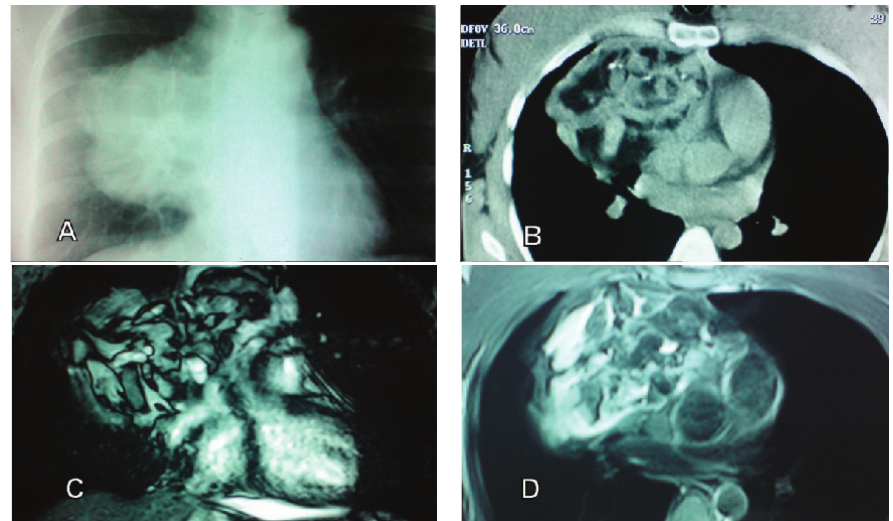
Figure 1: (A) Mediastinal lesion on chest radiography. (B) A mass with heterogenous density and calcifications in anterior mediastinum on thorax CT. (C) and (D), heart and main vascular structures are displaced by the mass on thoracic MRI.